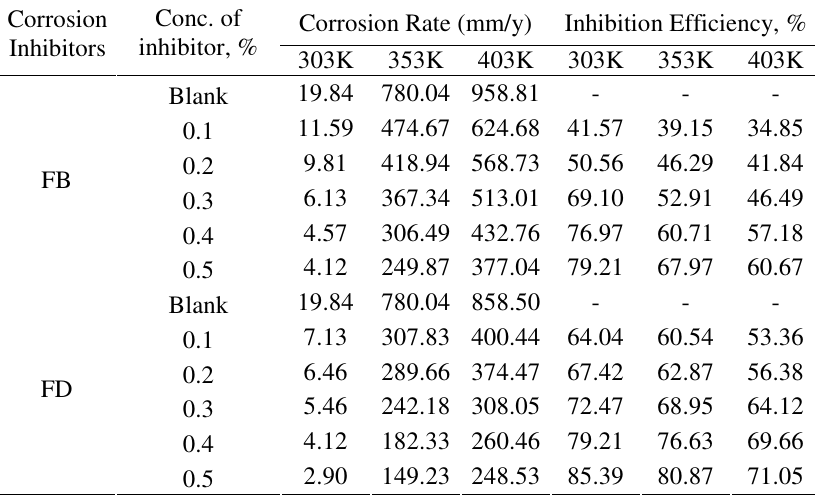
Table 1. Corrosion inhibition behaviour of mild steel in 1.11N HCl solution in absence and presence of FB and FD by weight loss